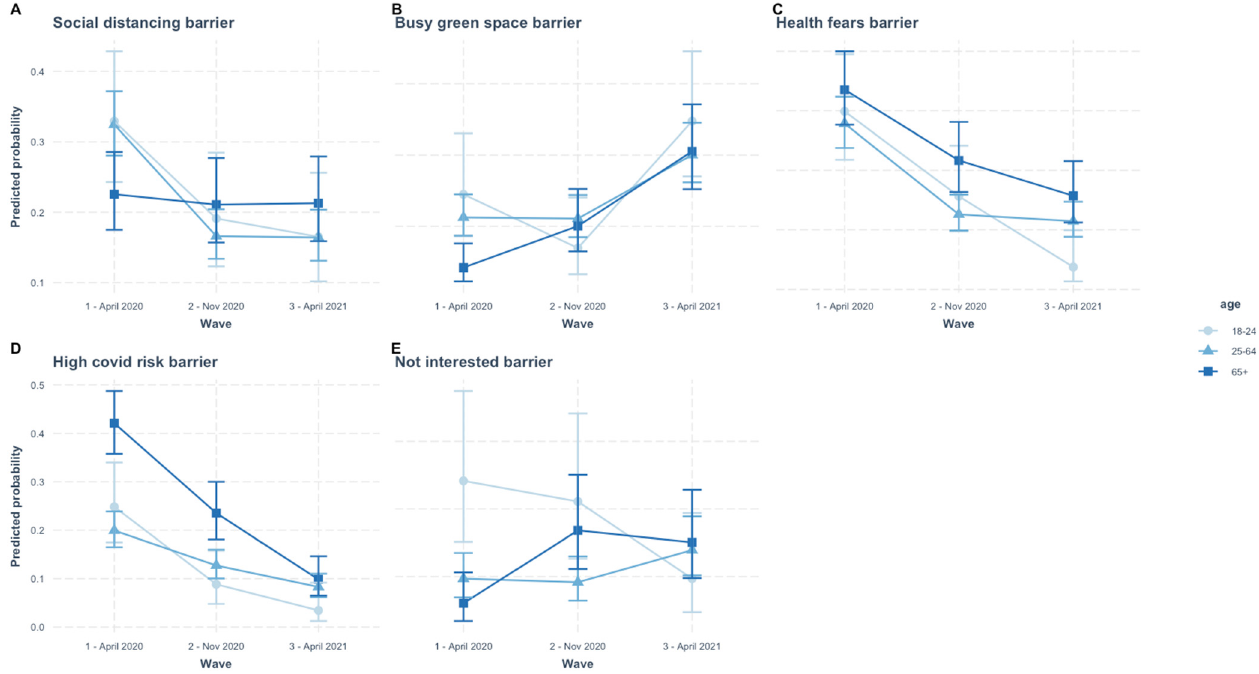
Figure 4. Predicted probabilities from logistic regression models with significant interactions between wave and age-group for: ( A ) the barrier ‘I am worried I will not be able to socially distance’, ( B ) the barrier ‘green spaces are too busy’, ( C ) the barrier ‘I fear for my health when I go outdoors’, ( D ) the barrier ‘I/a member of my household is at higher risk of being severely affected by coronavirus’, and ( E ) the barrier ‘I am not interested in visiting green spaces’.